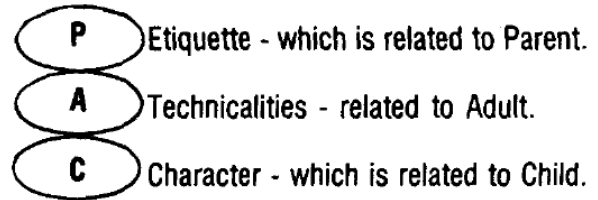
Figure 16: ‘Personality’ of a Culture (Drego, 1983,